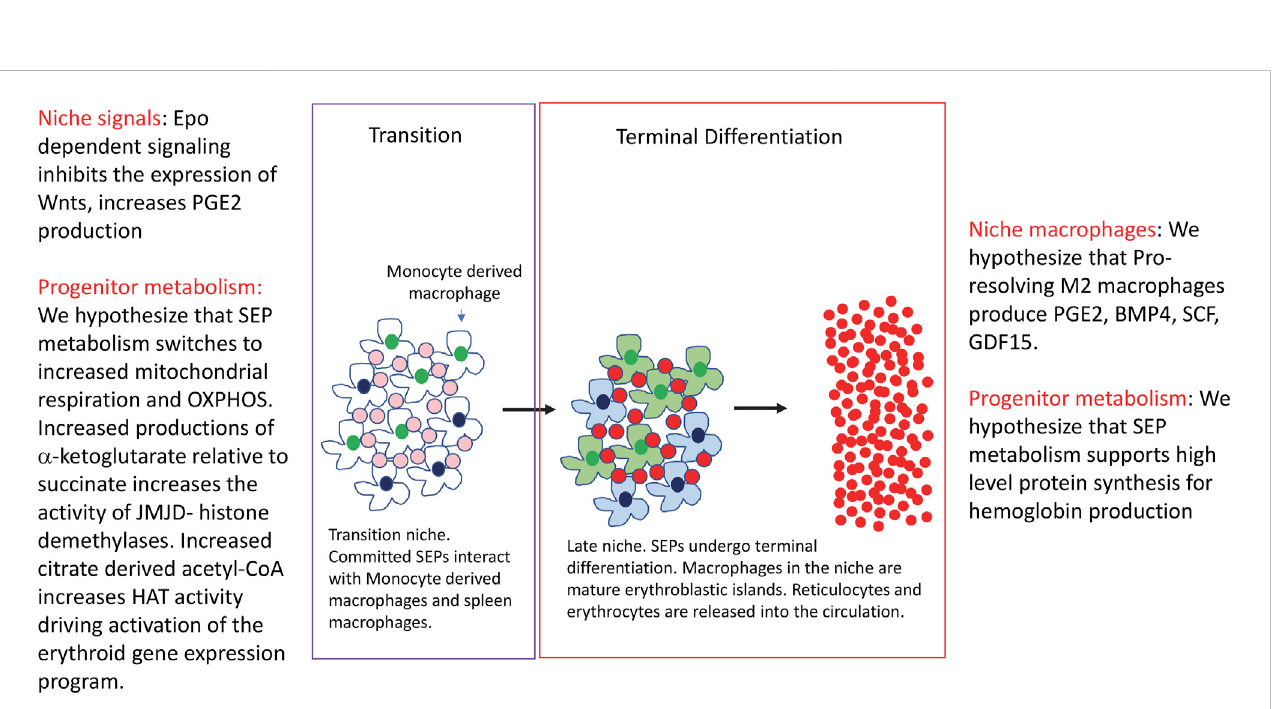
FIGURE 2 The transition to differentiation and the terminal differentiation of stress erythroid progenitors. The fi gure depicts the transition to differentiation and terminal differentiation. Changes in signals and metabolism in the niche and progenitors are